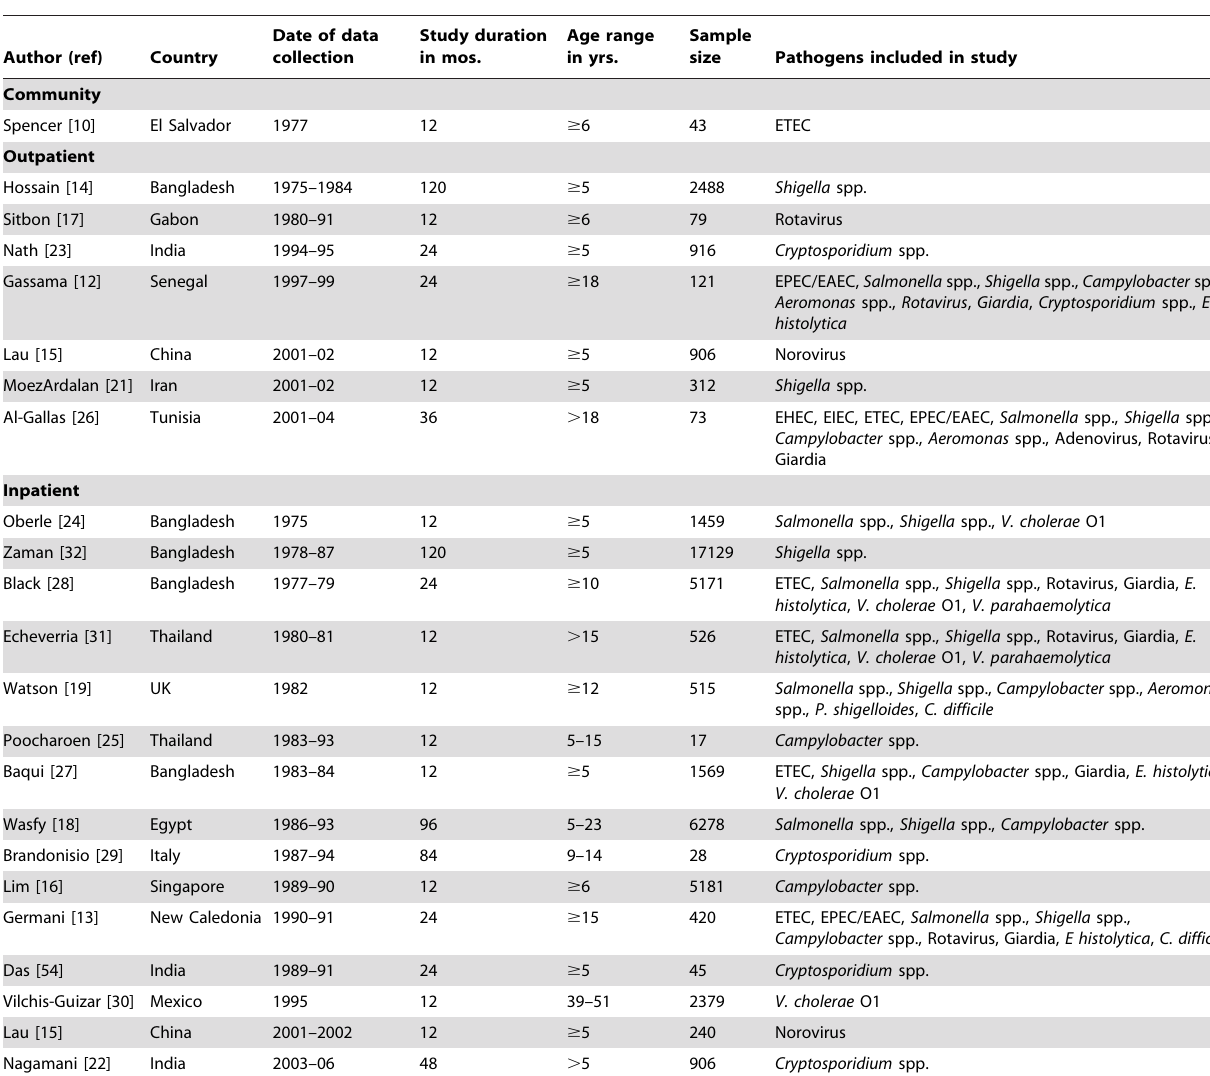
Table 2. Study characteristics of community based, inpatient, and outpatient studies included in the final